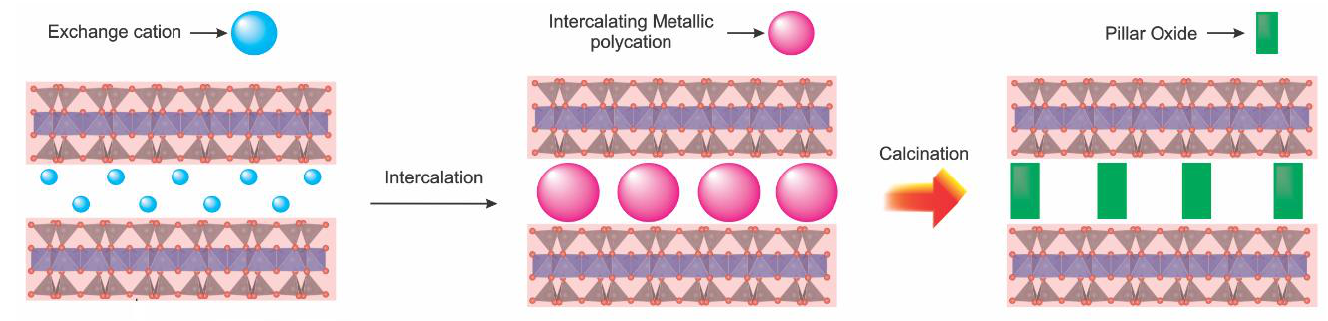
Figure 7. Schematic representation of the pillarization process of clay minerals.